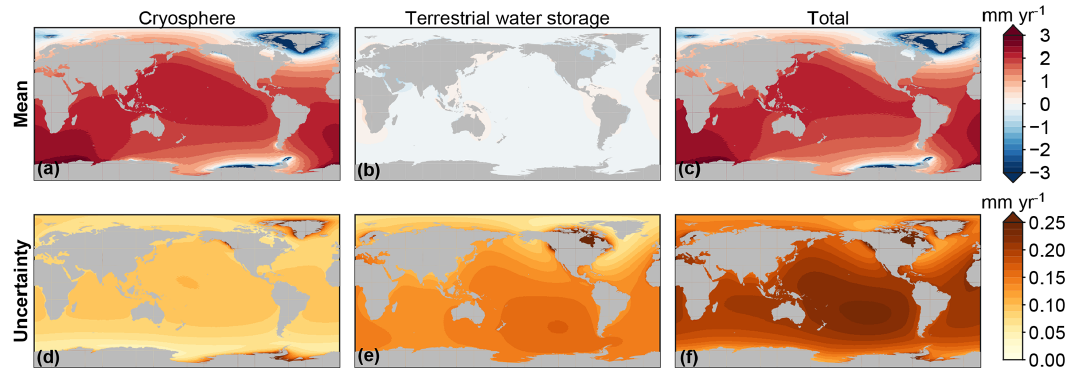
Figure 7. Trends in RSL resulting from mass redistribution observed by GRACE, separated into the cryosphere contribution (sum of glacier and ice sheet contribution), the TWS contribution, and the total land mass contribution. The trends have been computed over the full GRACE time span (2002–2017). Panels (a) – (c) show the mean trend, and panels (d) – (f) show the uncertainty.